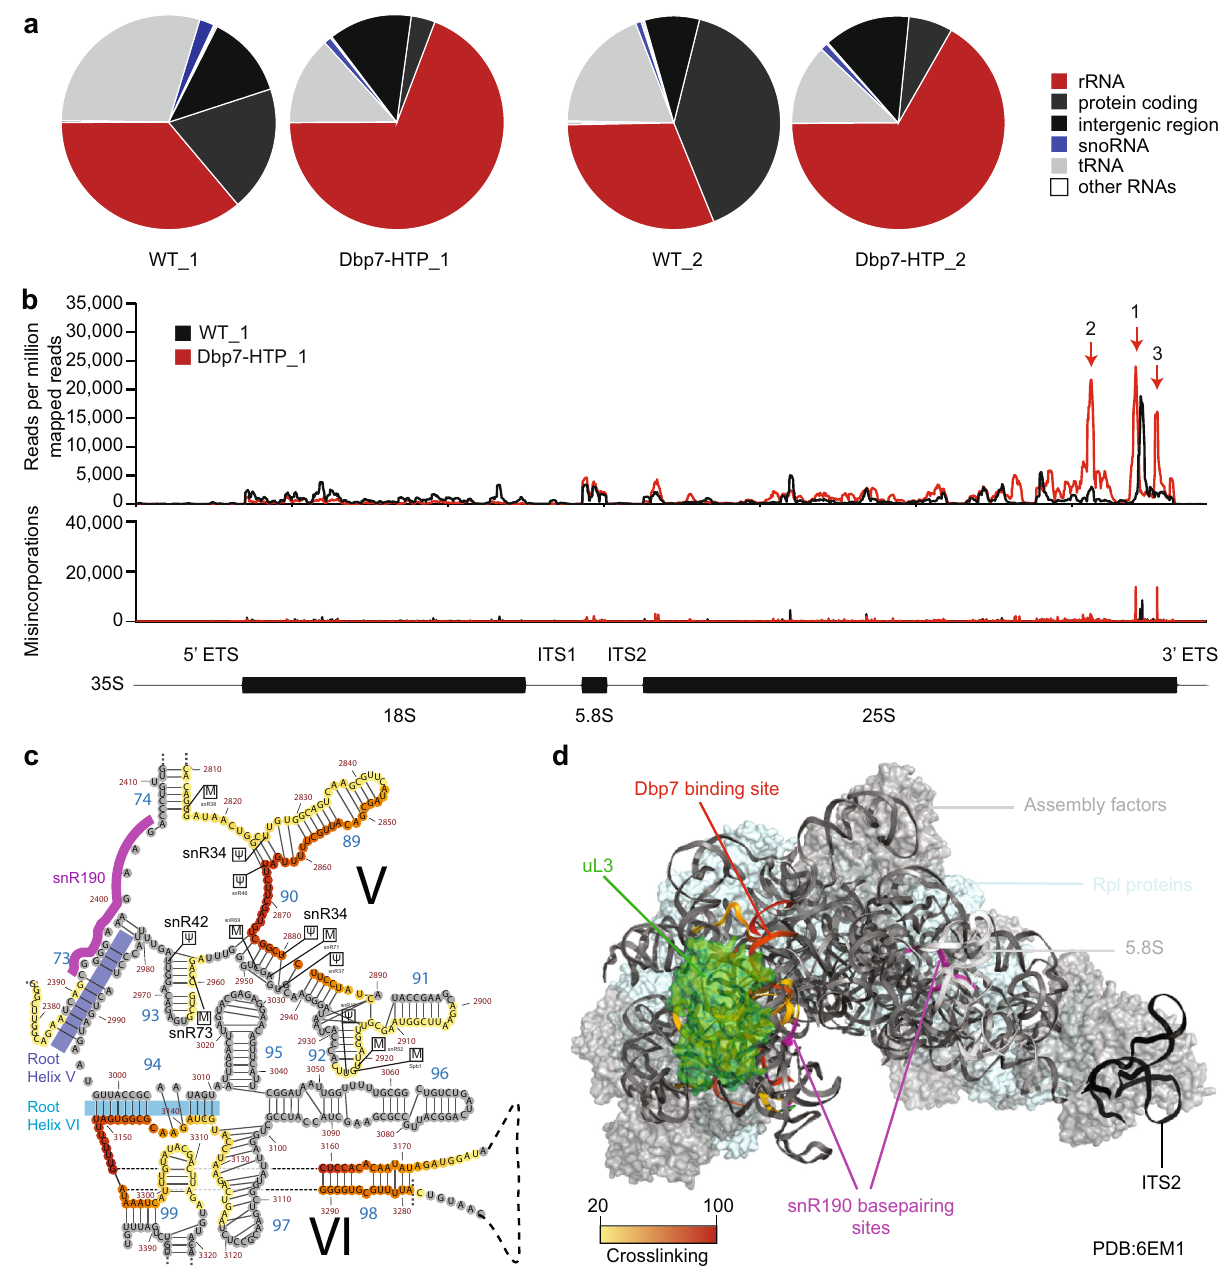
Fig. 4 Dbp7 cross-links to domain V and VI of the 25S rRNA sequence. a The relative numbers of reads mapping to genes encoding different RNA species in the wild-type control (WT) and Dbp7-HTP PAR-CRAC samples are presented as pie charts. Highlighted in red and blue are the proportions of reads mapping to the rDNA locus and snoRNA genes, respectively. Data from two independent PAR-CRAC experiments are shown. b The normalized numbers of reads mapping to each nucleotide of the RDN37 rDNA transcription unit in the Dbp7-HTP and WT samples are shown in the upper panel. The normalized number of the T-to-C misincorporations mapping to each nucleotide of RDN37 is shown in the lower panel. A schematic representation of the 35S pre-rRNA transcript is shown at the bottom with black rectangles corresponding to the mature rRNAs and black lines representing the transcribed spacers. c A magni fi ed view of the domain V and VI regions of the 25S rRNA secondary structure, containing the three major Dbp7-HTP cross-linking sites is shown. The number of sequencing reads mapping to each nucleotide of 25S rRNA is represented by a color code where the maximum number of reads (100%) is shown in red and lower numbers of reads (down to 20%) are shown in orange-yellow. The predicted basepairing site of snR190 is indicated by a purple line, and the domain V and VI root helices are indicated in blue and cyan, respectively. d Modeling of the identi fi ed Dbp7-HTP cross-linking sites onto a tertiary structure of the 25S rRNA in the state C nucleolar pre-60S particle puri fi ed via TAP-tagged Nsa1 followed by Flag-tagged Ytm1 (PDB: 6EM1) using a color scale as in ( c ). The density corresponding to uL3 is colored in green and snR190 basepairing sites are indicated in purple. In panels ( b – d ), data from a single, representative PAR-CRAC dataset is